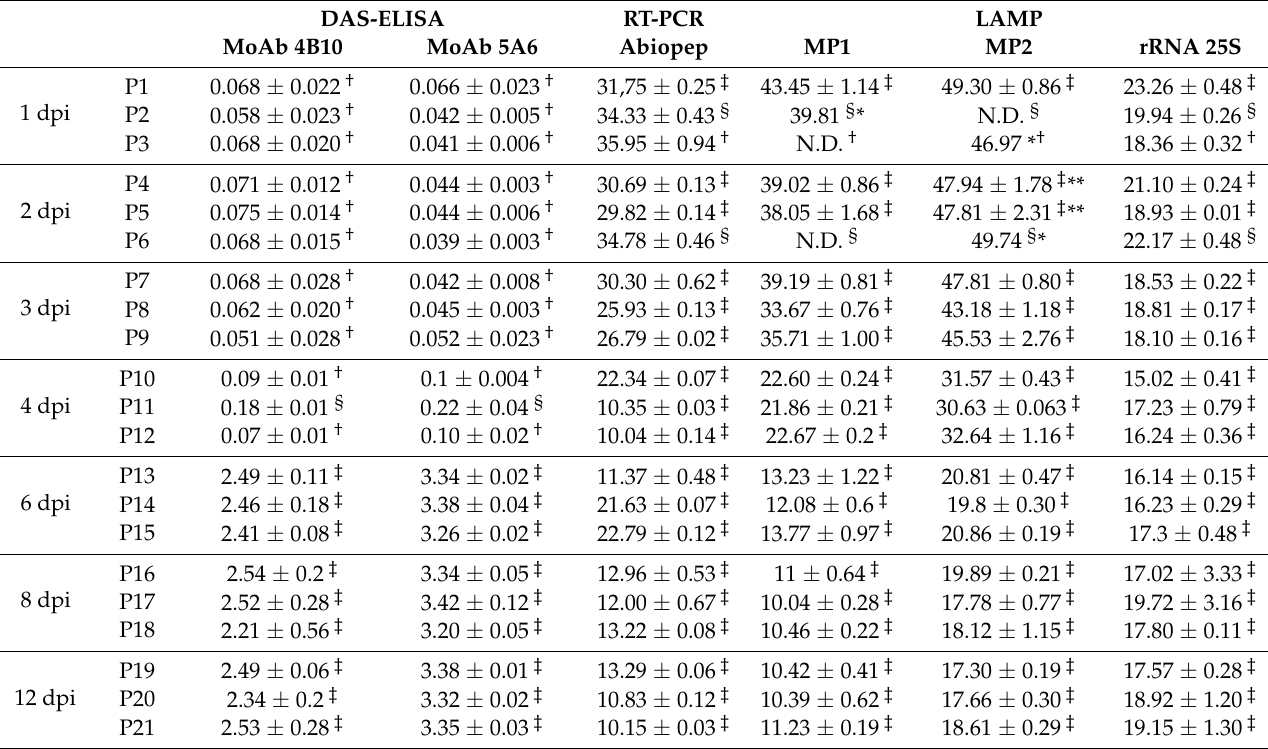
Table 1. Comparison of ToBRFV detection